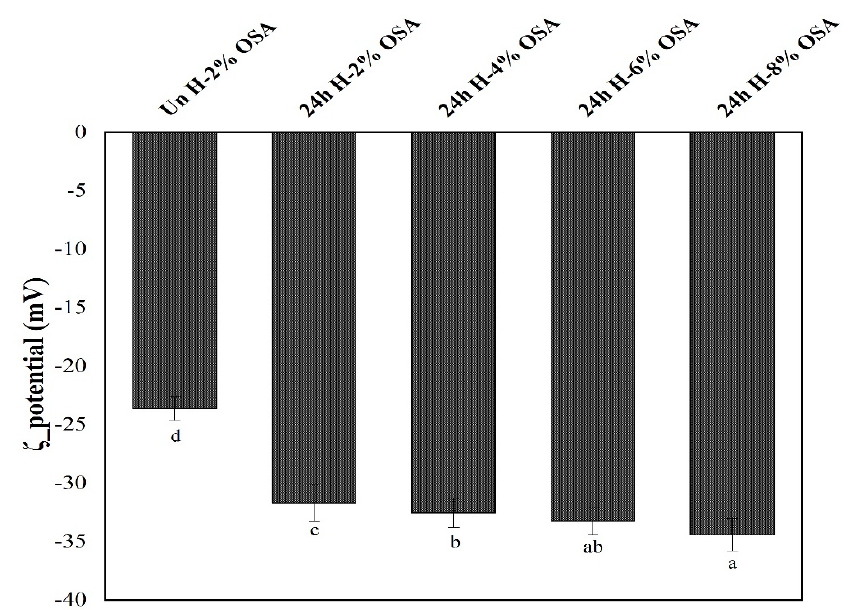
Figure 7. ζ -potential of fresh emulsions stabilized by high-amylose PMS (Kudzu) starch with different OSA concentrations. The significant difference of the same indicator is indicated with different letters in different samples ( p < 0.05).